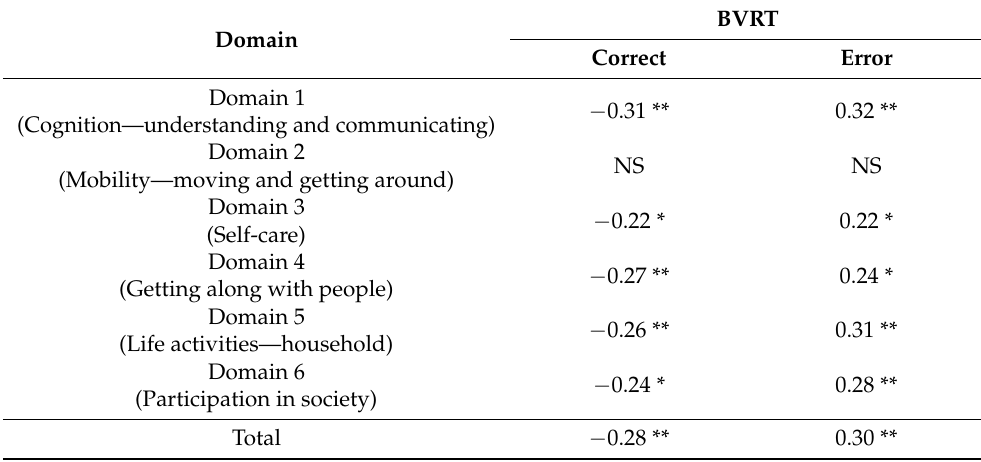
Table 7. Correlations with Benton visual retention test (BVRT).